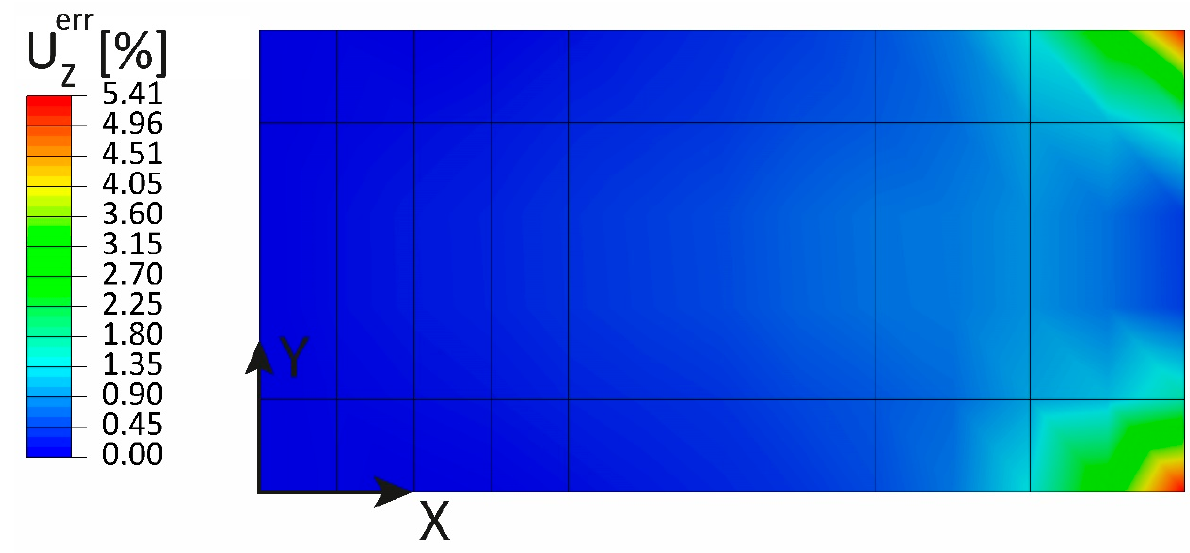
Figure 12 . Out-of-plane tip loading: percentage error of the 𝑈 (cid:3027) displacement. Figure 12. Out-of-plane tip loading: percentage error of the U Z